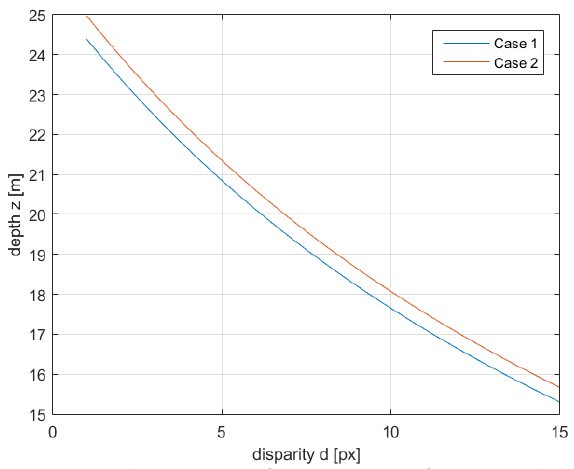
Figure 7. Residuals of image coordinates of all images. From Figure 8. Calculated depth for a chosen set of disparity values. top: Left camera with windshield, right camera with windshield, Case 1: Images through windshield (lower curve). Case 2: left camera without windshield, right camera without Images not through windshield (upper curve). Approx. 0.5m windshield. difference in depth values for a certain disparity